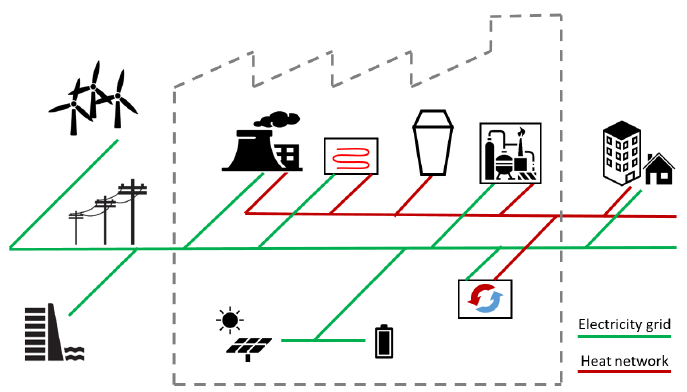
Figure 1. Sketch of the target use case: a typical industrial energy